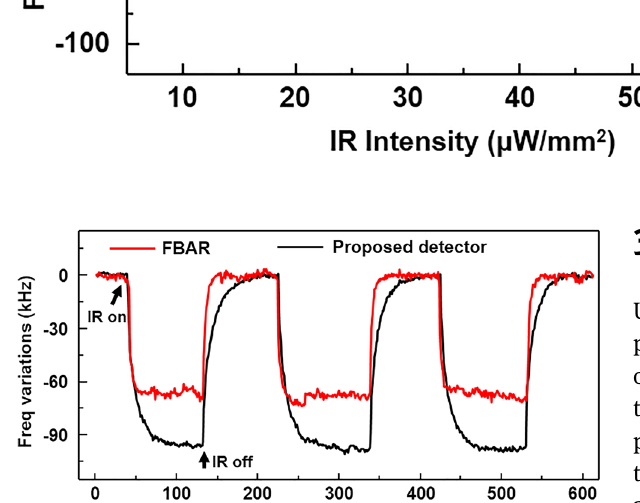
Figure5: Measuredresponseoftheproposedsensorandabarefilm bulk acoustic wave resonator (FBAR) to modulated infrared (IR) radiation (58 μ W/mm 2 ). The proposed sensor shows 1.5 × enhanced